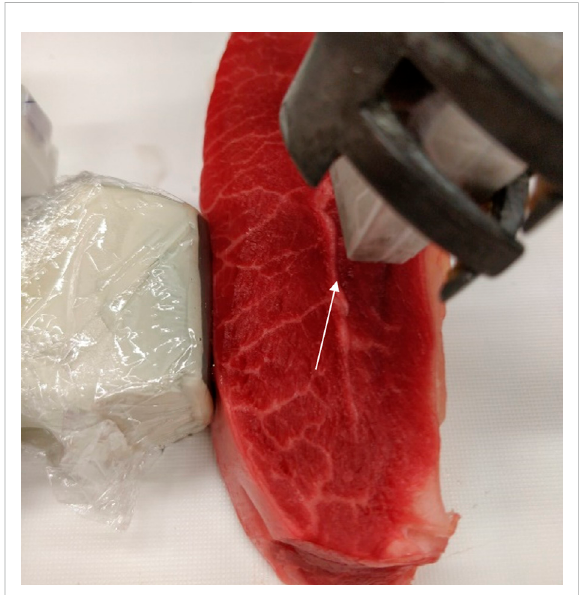
FIGURE 4 Picture of the imaged bovine sample. A horizontal lipid streak is visible throughout the sample at a depth of ~25 mm that is marked with a white arrow. The sample is illuminated from the top (1,200 nm) and the ultrasound transducers were positioned on the